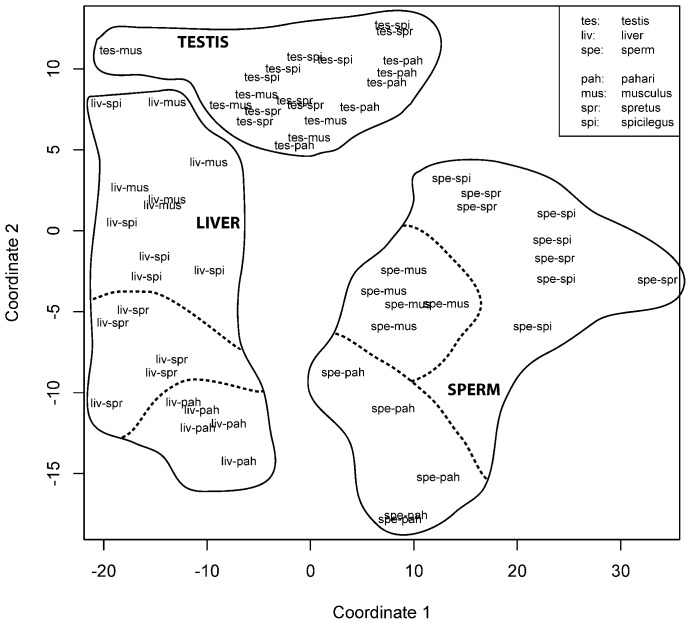
Representation of fatty-acid composition by tissue type and by species.Non-metric multidimensional scaling analysis of fatty-acid composition showing separation of samples by tissue type and partly separation by species within liver samples and sperm samples (n = 5 for each species, except n = 4 in the case of sperm data for M. spretus). Closer distances between any two samples reflect greater similarity in their fatty-acid composition.